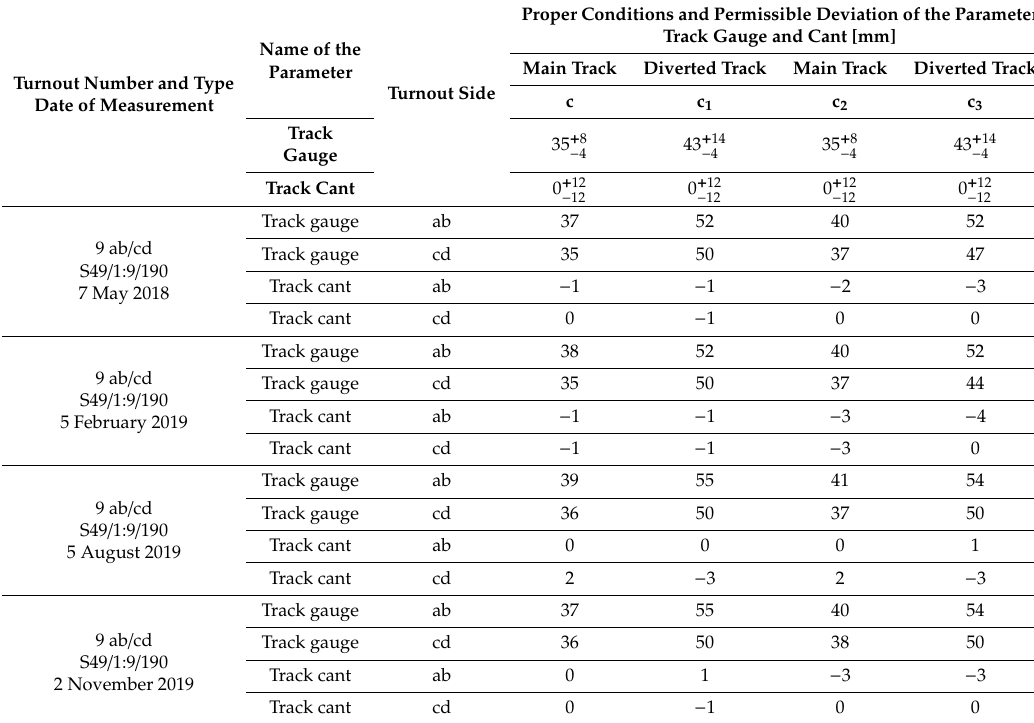
Table 4. Values of the track gauge and cant parameters in the switch at points c, c 1 , c 2 , and c 3 —periodic monitoring of four additional Rkpd iwew types S49 / 1:9 / 190.